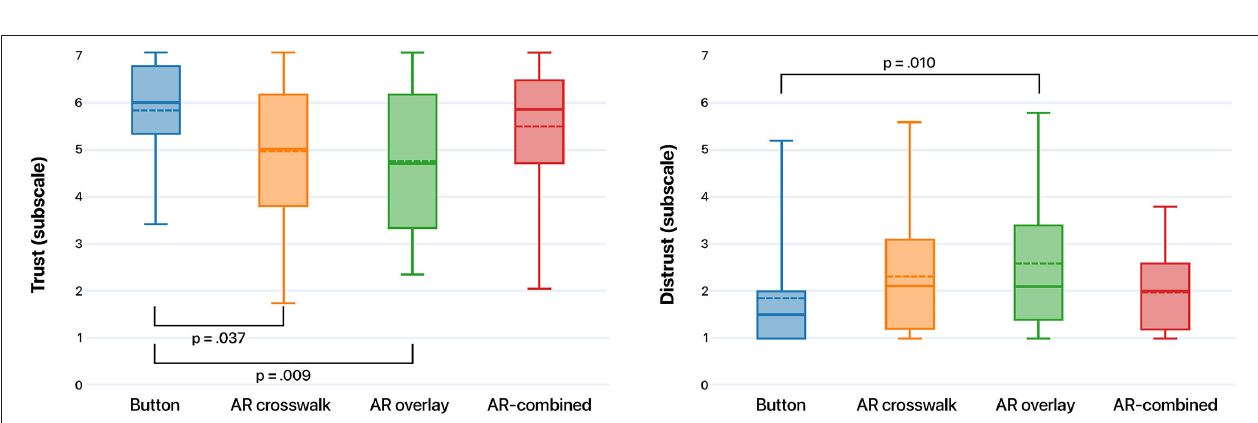
FIGURE 7 | Results of the Trust Scale questionnaire: trust subscale (left) and distrust subscale (right). Median = solid line; mean = dotted line, p -values reported for significant pairwise